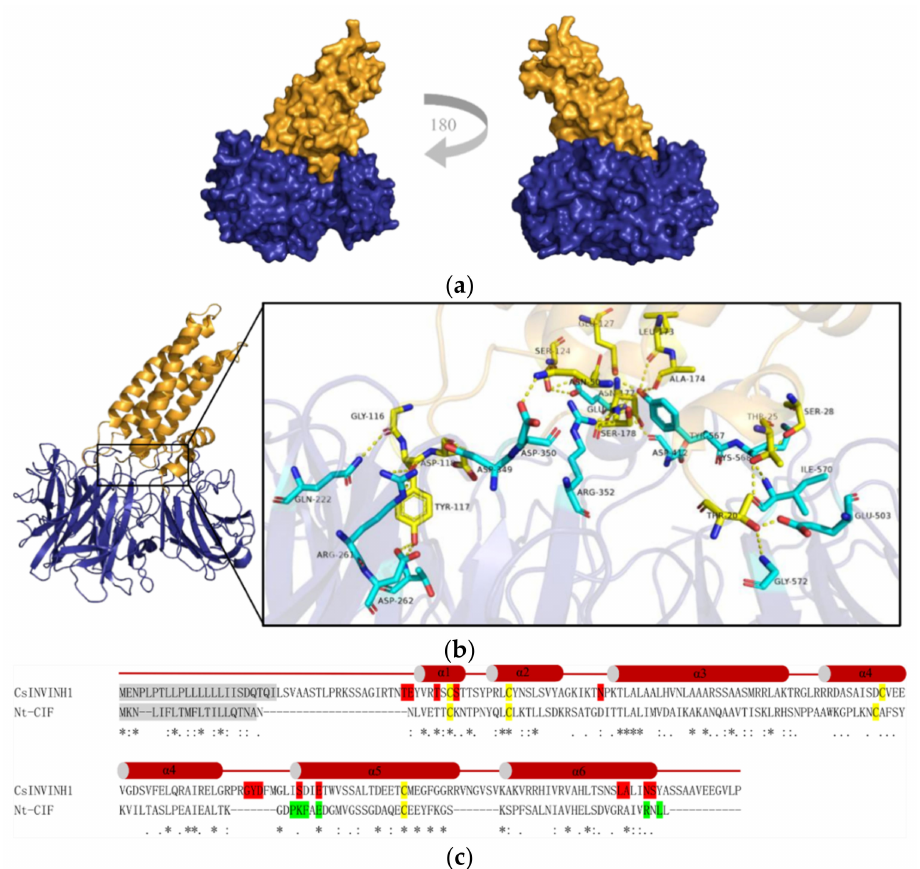
Figure 11. Modeled structure of proposed CsVI1/CsINVINH1 complex shows that CsINVINH1 might interact with CsVI1. ( a ) Overall structure of the proposed CsVI1 (blue)/CsINVINH1 (yellow) complex. ( b ) The interface between the proteins is comprised of conserved amino acids or motifs of the modeled interacting proteins (right, close-up view of the proposed interacting regions). The yellow amino acids are from CsINVINH1, and the blue amino acids are from CsVI1. Hydrogen bonds are shown as yellow dotted lines. ( c ) Amino acid sequence comparison of CsINVINH1 and NtCIF. For the proposed CsVI1/CsINVINH1 complex, all the putative binding sites in CsINVINH1 are shaded in red. For the AtCWI1/NtCIF complex, the key binding sites in NtCIF are shaded in green. The signal peptide sequence is shaded in gray, and an invariant cysteine of invertase inhibitors in yellow. Asterisks indicate identical residues, colons indicate conserved substitutions, and periods indicate semi-conserved